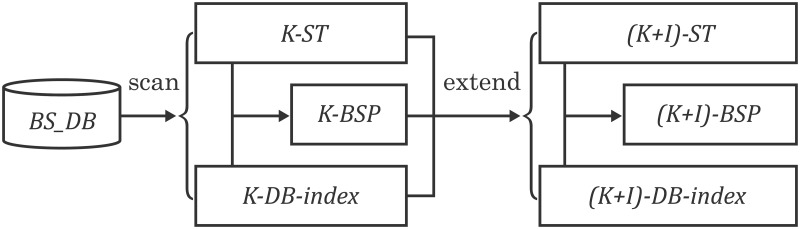
Algorithm model.